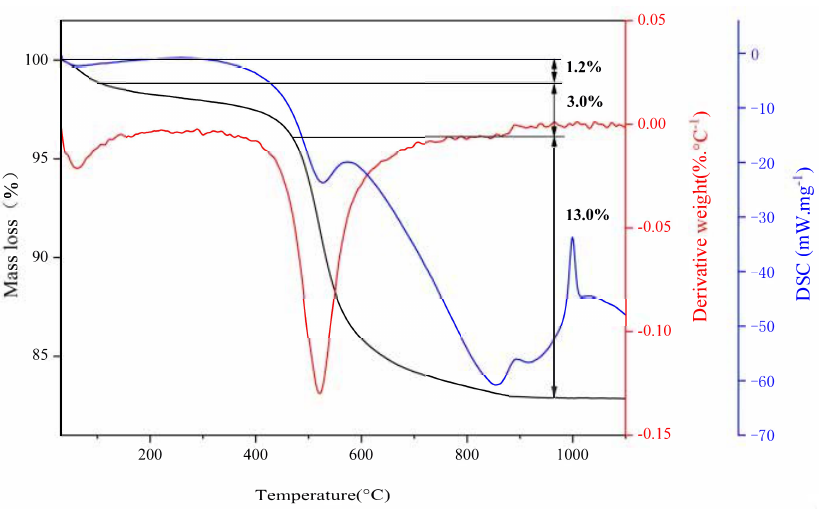
Figure 1. XRD patterns of starting samples: ( a ) RCG; ( b ) ACG.